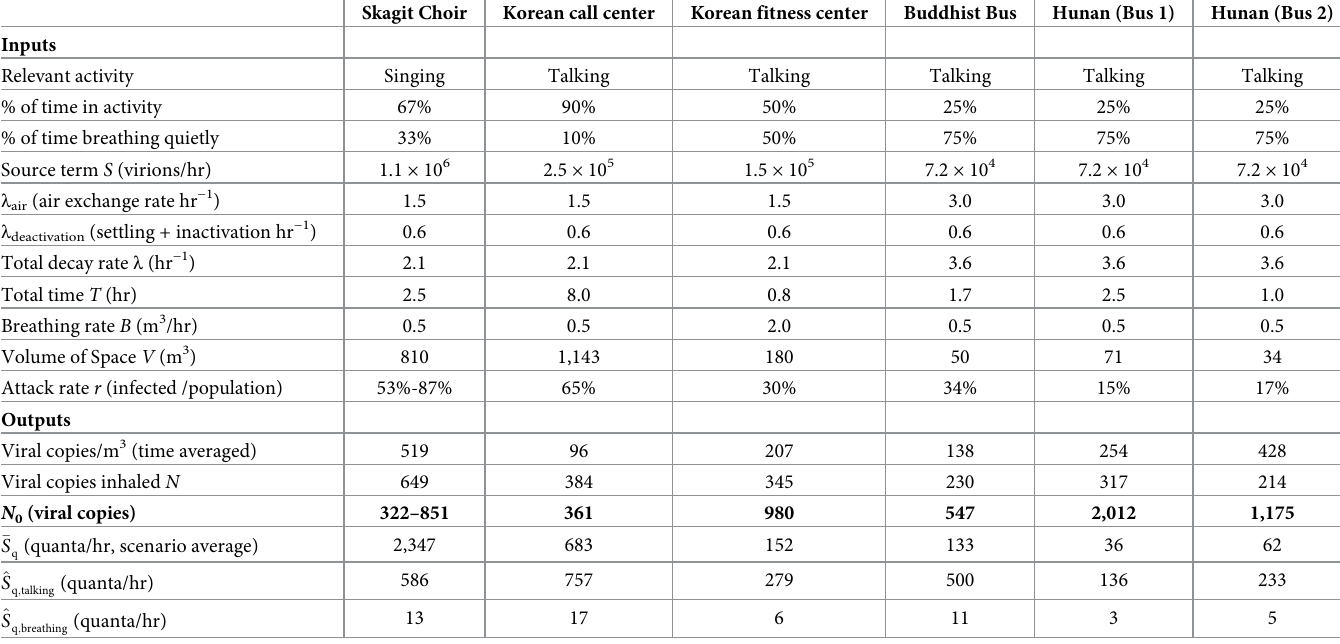
Table 2. Key inputs and outputs for the case studies. (Refer to the spreadsheet S1 Table in the Supporting Information for details). The quanta/hour (scenario average) refers to the quanta emission rate averaging the high and low attack rate cases, for the particular parameters of that scenario. The quanta/hour (talking, breathing) are the implied quanta/hour for talking and